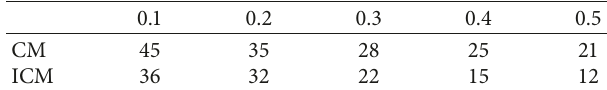
Figure 3: Message complexity.